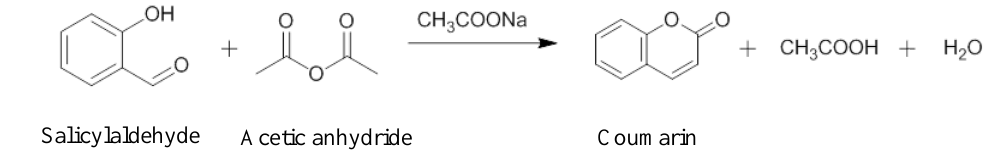
Figure 2. Reaction scheme for the synthesis of coumarin